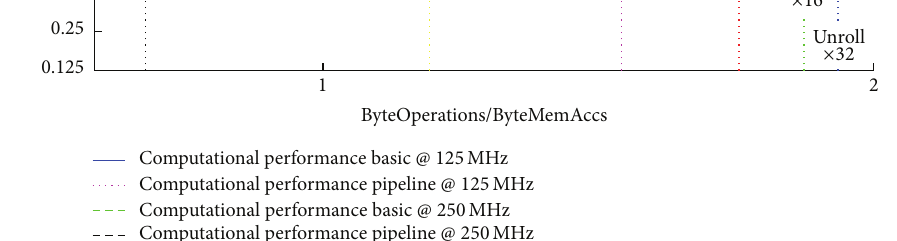
Figure 7: Roofline model including several designs of Erosion using Vivado HLS and with one FPGA.